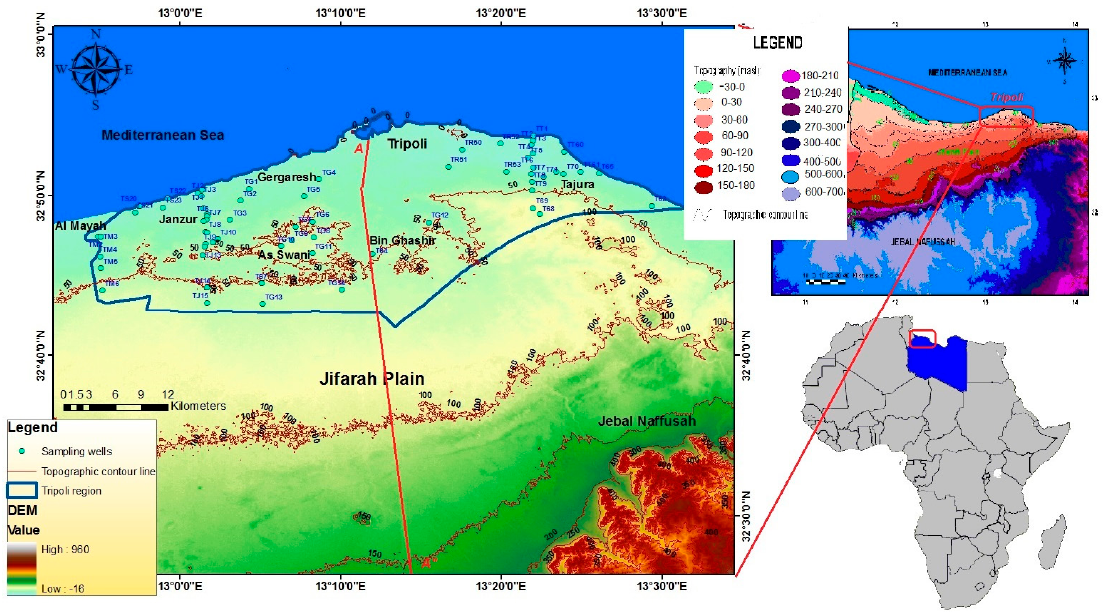
Figure 1. Location and topography of the study area in Jifarah Plain North West, Libya.